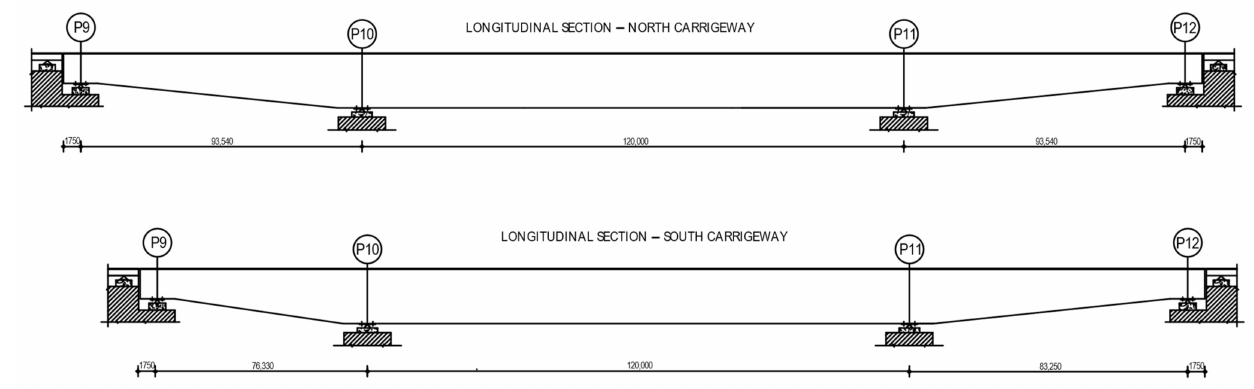
Figure 11. Longitudinal view of the two carriageways of the case study.